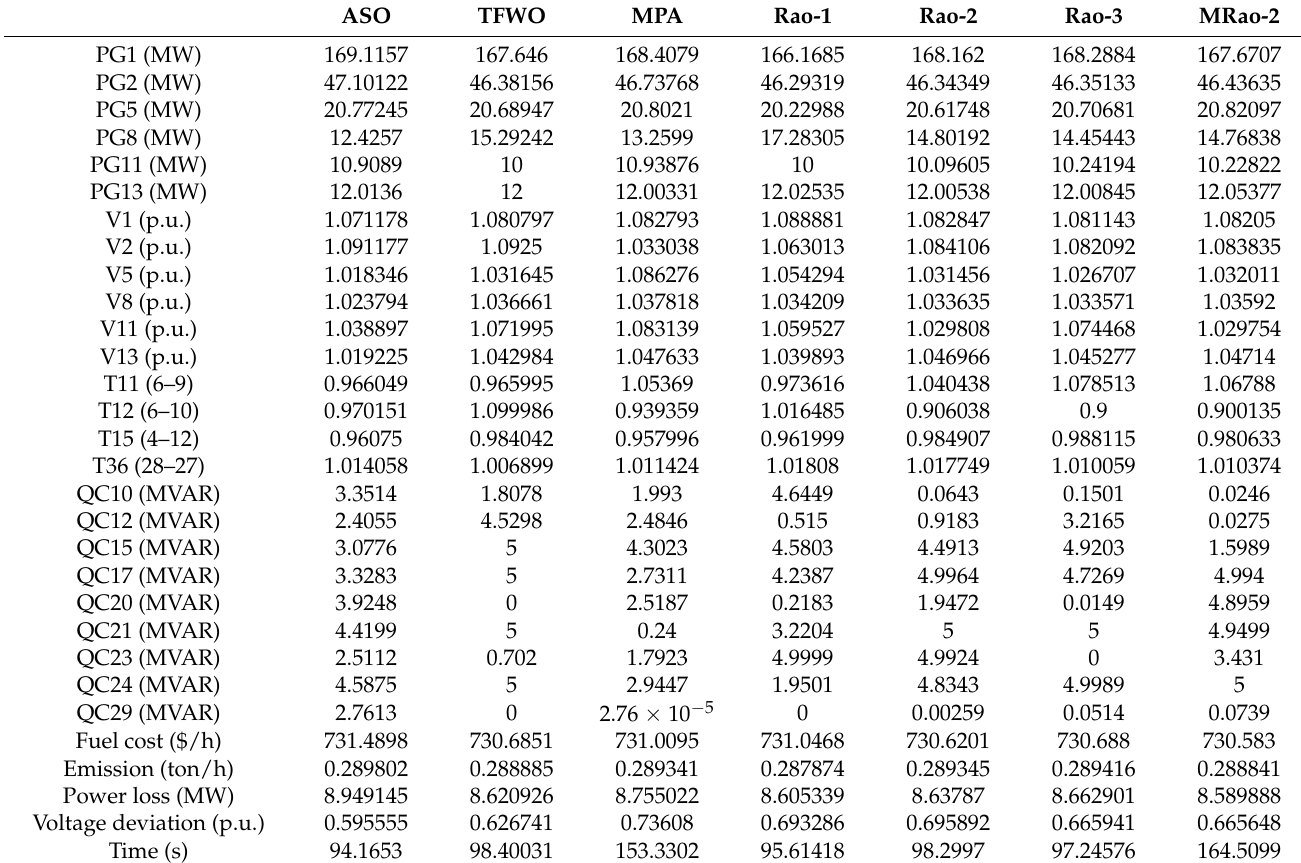
Figure 9. Boxplot graph of best Fuel cost in 20 runs of the proposed MRao-2 and other recent algorithms for case 2. Table 7. Results of the proposed method and other methods for case